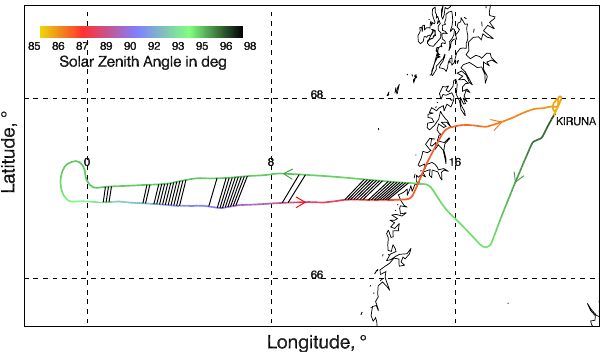
Fig. 3. Flight path of the RECONCILE self-match flight on 30 Jan- uary 2010. The solar zenith angle on the track is represented by the colour scale. The black lines between outbound and inbound parts of the flight represent the trajectories of the match pairs fulfilling the strict match conditions (cf. Sect.